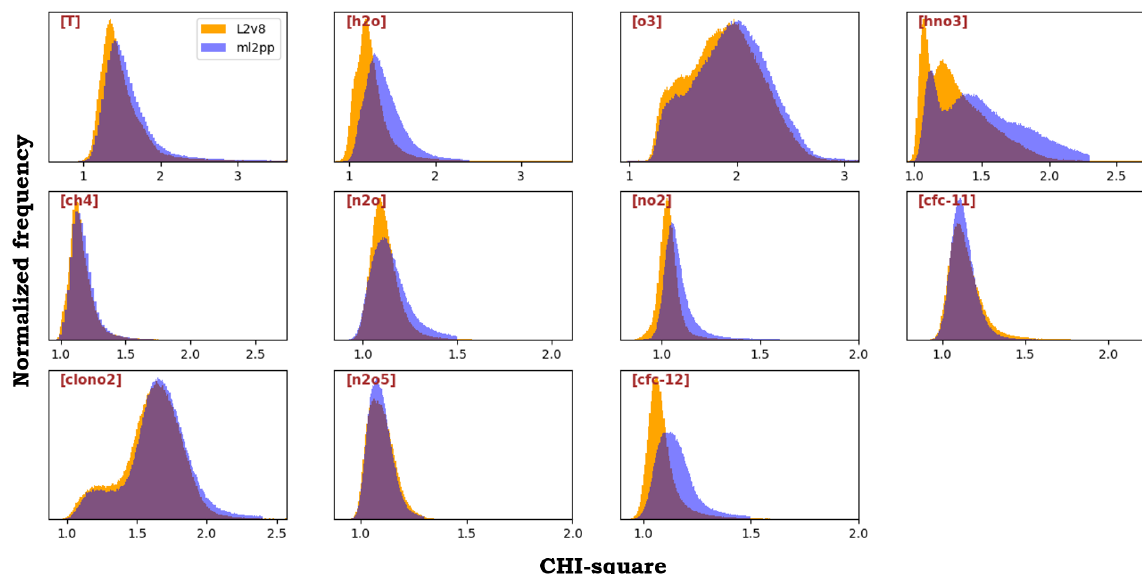
Figure 1. Chi-square distribution of all FR NOM L2 V8 (orange) and L2 V7 (blue) profiles for some representative trace species.